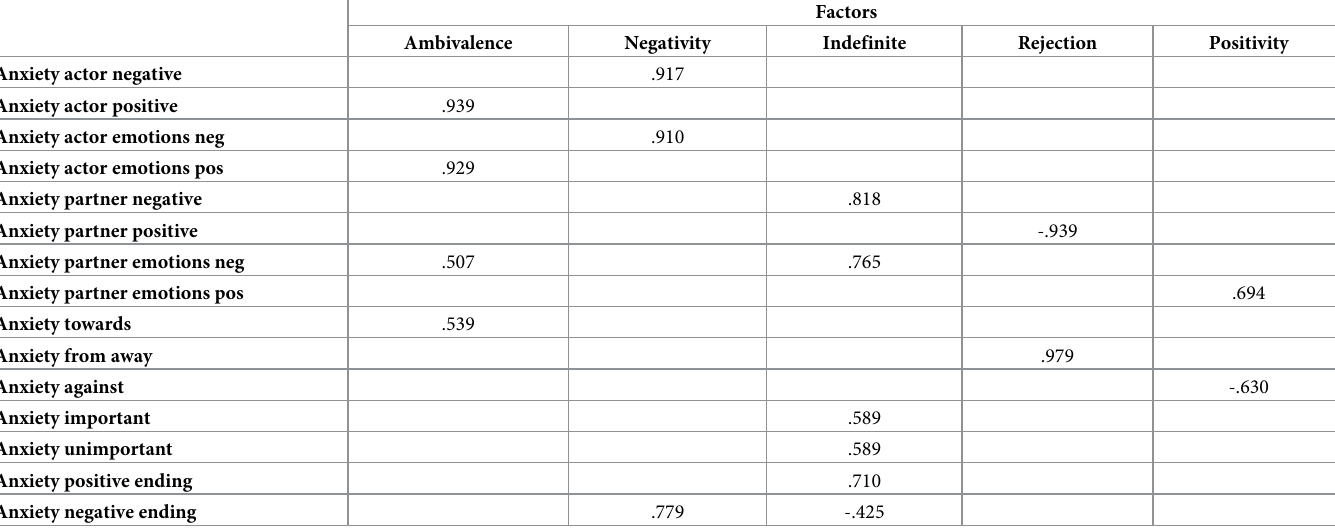
Table 5. Anxiety: Exploratory factor analysis for narrative indicators ( n = 200).